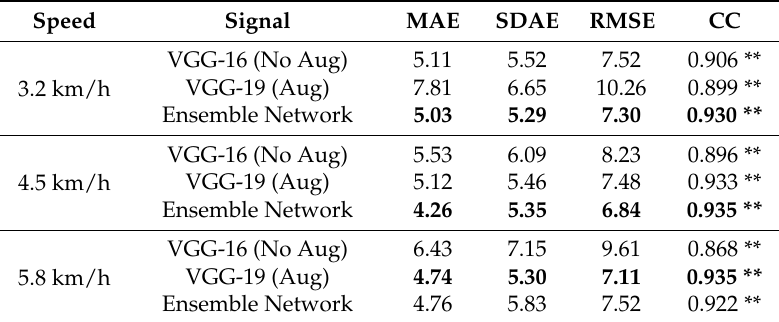
Table 4. Estimation of heart rate for walking by CNNs.